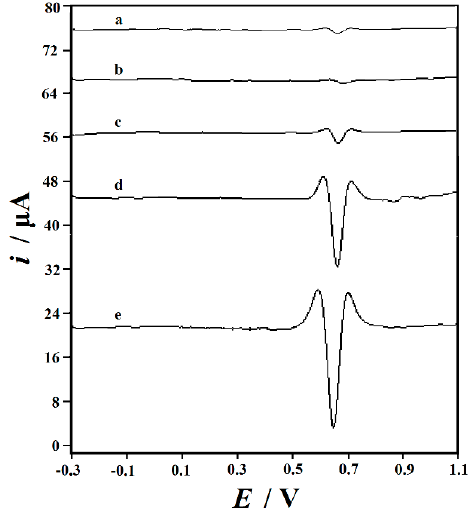
Figure 5. Second-order derivative linear scan voltammograms of 10.0 µM rutin on the different electrodes in 0.2 M H 2 SO 4 after accumulation at − 0.3 V for 210 s: GCE ( a ), GO/GCE ( b ), NH 2 -Fe 3 O 4 NPs-GO/GCE ( c ), ErGO/GCE ( d ), and NH 2 -Fe 3 O 4 NPs-ErGO/GCE ( e ). The scan rate of 0.1 V/s.